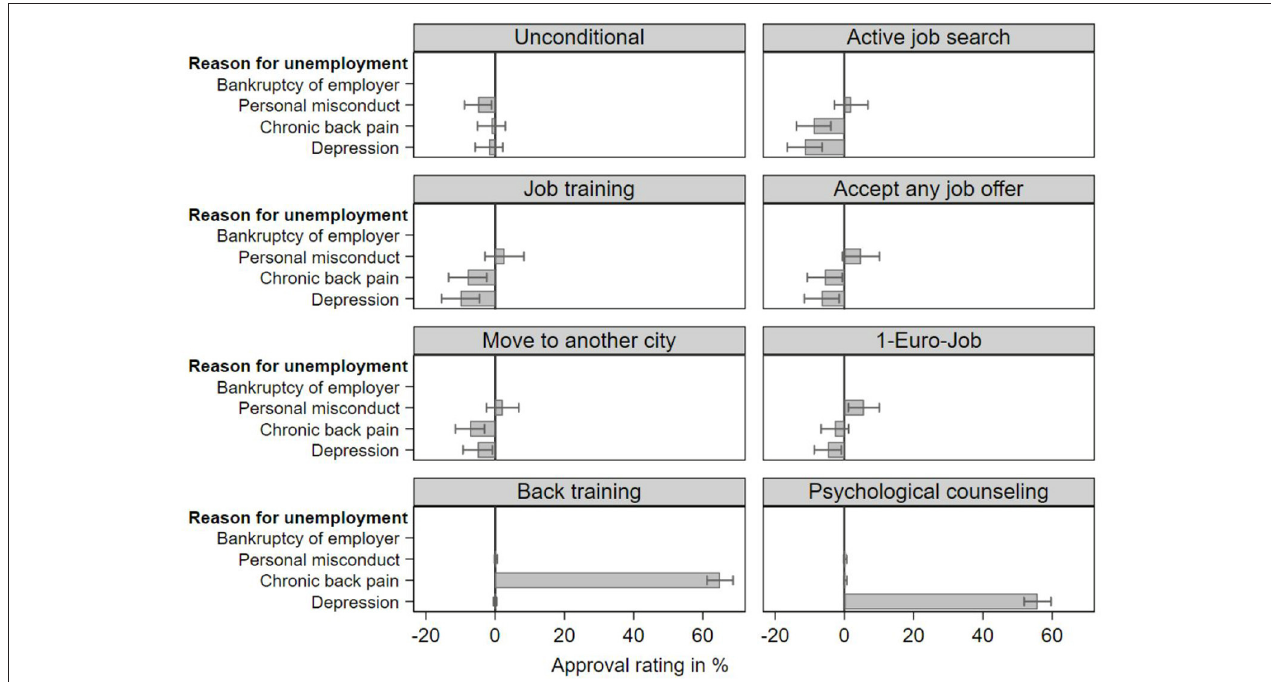
FIGURE 3 | Multivariate logistic regression coefficients and 95% confidence intervals of approval ratings for obligations to receive full minimum income benefits for different reasons of unemployment. Vignette study ( N = 2,621), own weighted sample calculations. Point estimates rescaled to percentage values. Model setup is the same as in the OLS-specification of benefits and sanctions ( Table 3